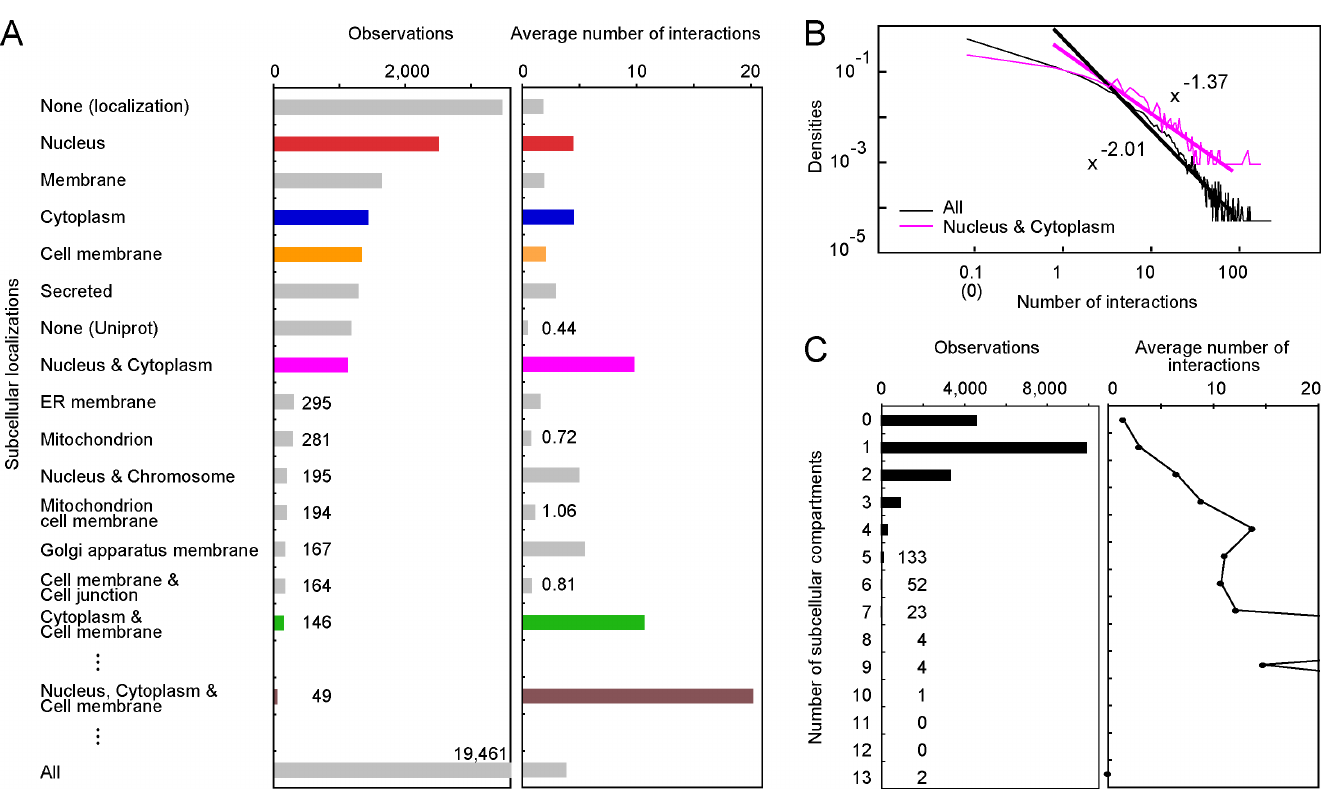
Fig 1. The statistics of the subcellular localizations and the numbers of interactions. A. The number of proteins (observations) in each subcellular localization and the average number of interactions are indicated, in the descending order of the observations. The data for NP, CP, MP, NCP, CMP, and NCMP are colored red, blue, orange, magenta, green and brown, respectively. None (locatization) means that no subcellular localization was denoted in Uniprot, and None (Uniprot) means that no Uniprot entry was assigned to the HPRD entry. The observations represented by the short bars are shown as numbers, and the number by the bottom bar is the total number of HPRD entries. B. The distribution of the number of interactions in the log-log plot. When the number of interactions was zero, the data are shown at 0.1 interactions. The distribution was approximated by the power function, using the data from 1 to 100 interactions. The scaling exponents are -2.01 and -1.37 for the distributions of all proteins and the NCP, respectively. C. The statistics of the numbers of subcellular compartments for each HPRD entry, and the average number of interactions against the numbers of subcellular compartments. The full size view of the right panel is shown in S1